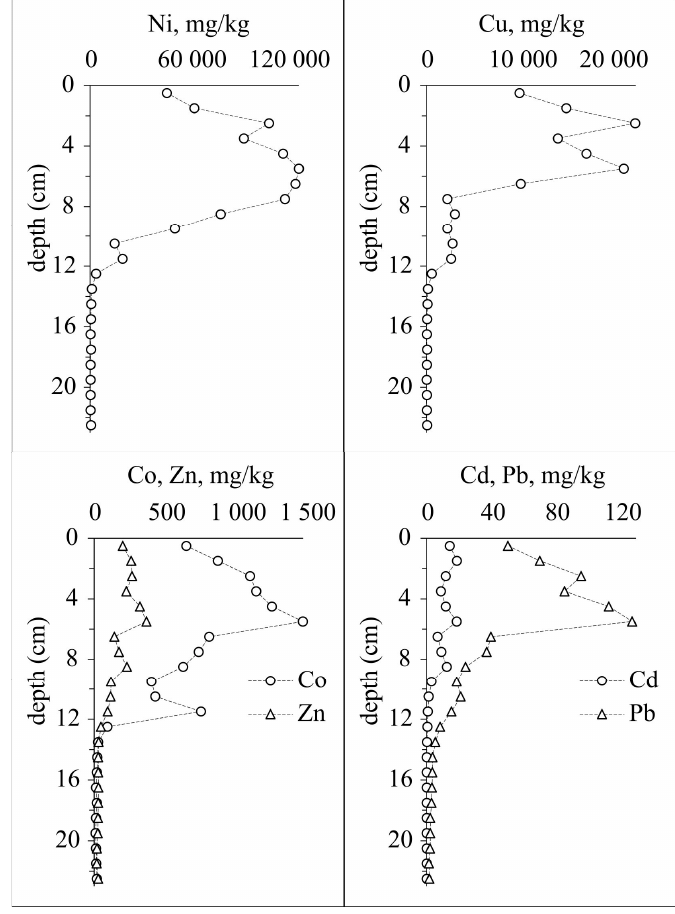
Figure 7. The vertical distribution of heavy metals in sediments of Lake Nudjavr (Murmansk Region) [21].